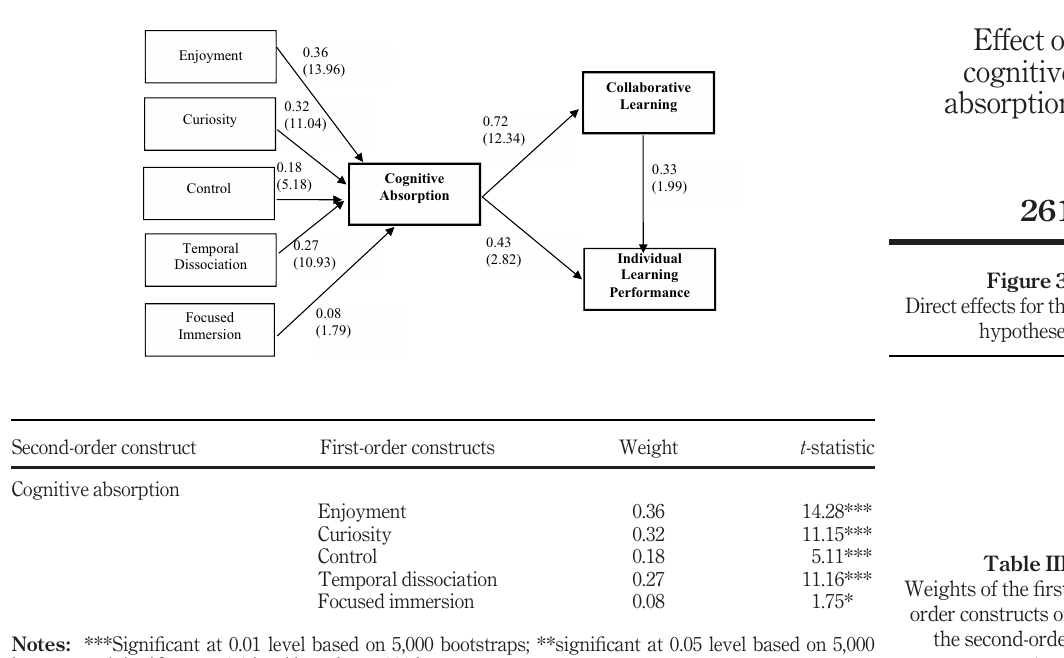
Figure 3. Direct effects for the